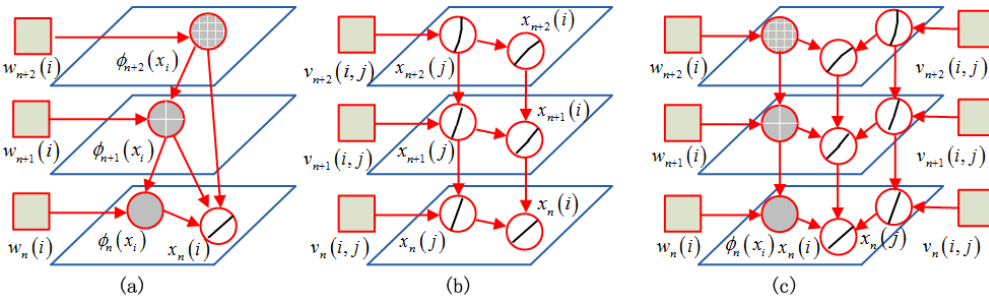
Figure 2. Multi-scale CRF structure conditioned on observation x n ( i ) . ( a ) Multi-scale likelihood in the unary potential; ( b ) multi-scale interaction in the pairwise potential; and ( c ) multi-scale CRF graph structure.